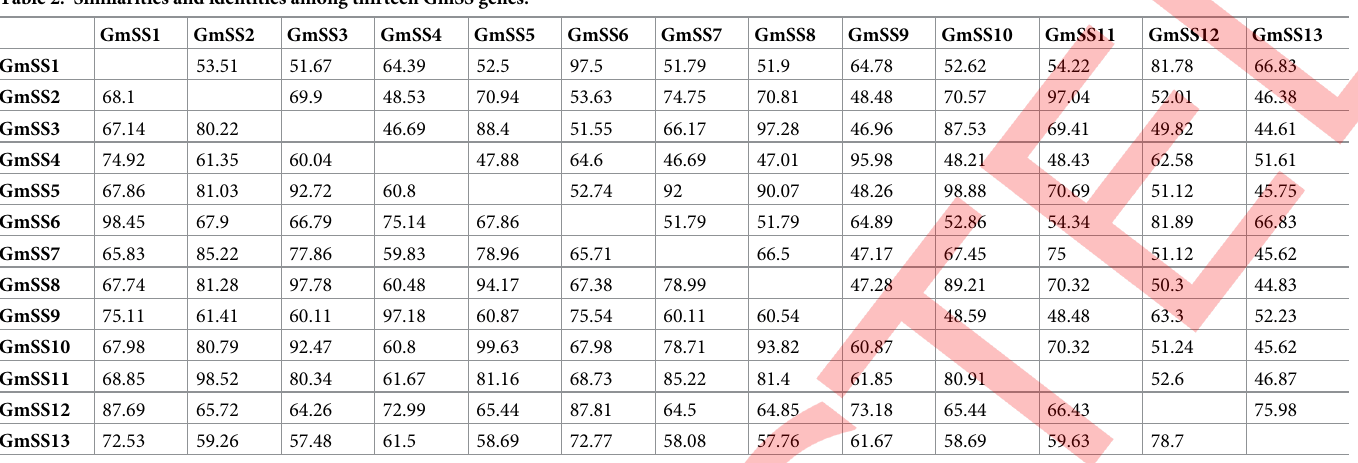
Table 2. Similarities and identities among thirteen GmSS genes.